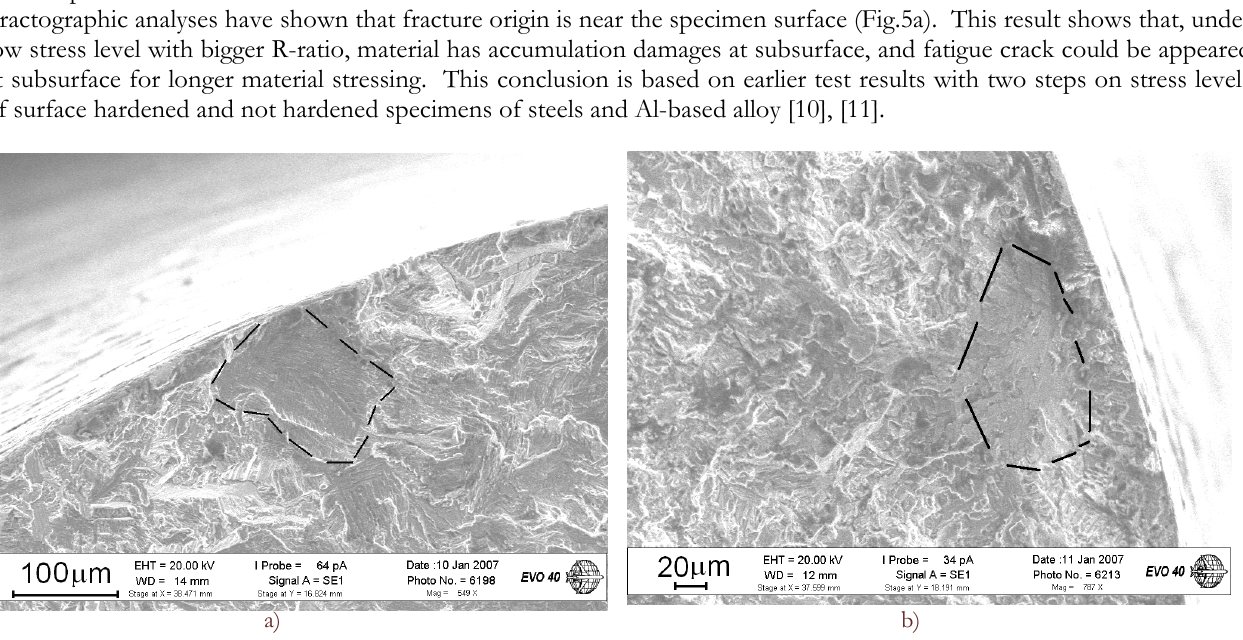
Figure 5. Fracture subsurface origin (inside of the dashed line) (a) in the T - specimen tested, first, under maximum stress level 730 MPa with R=0.64 up to 2.3 х 10 7 load cycles without failure and, then, tested under 790 MPa with R=0.5 up to 4.1 х 10 5 cycles with failure, and (b) in NTP – specimen tested up to 1.8 х 10 6 load cycles with